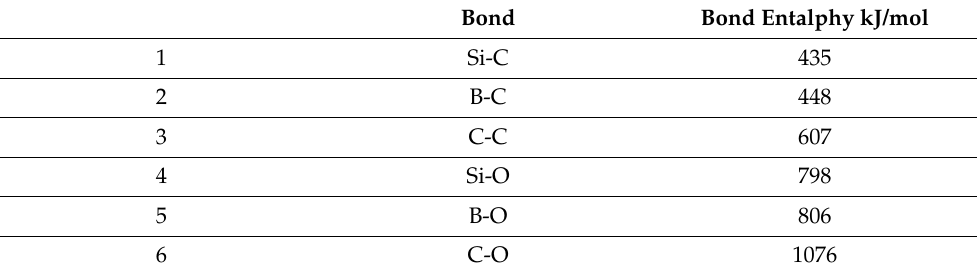
Table 1. Bond energy (according to reference [42]).